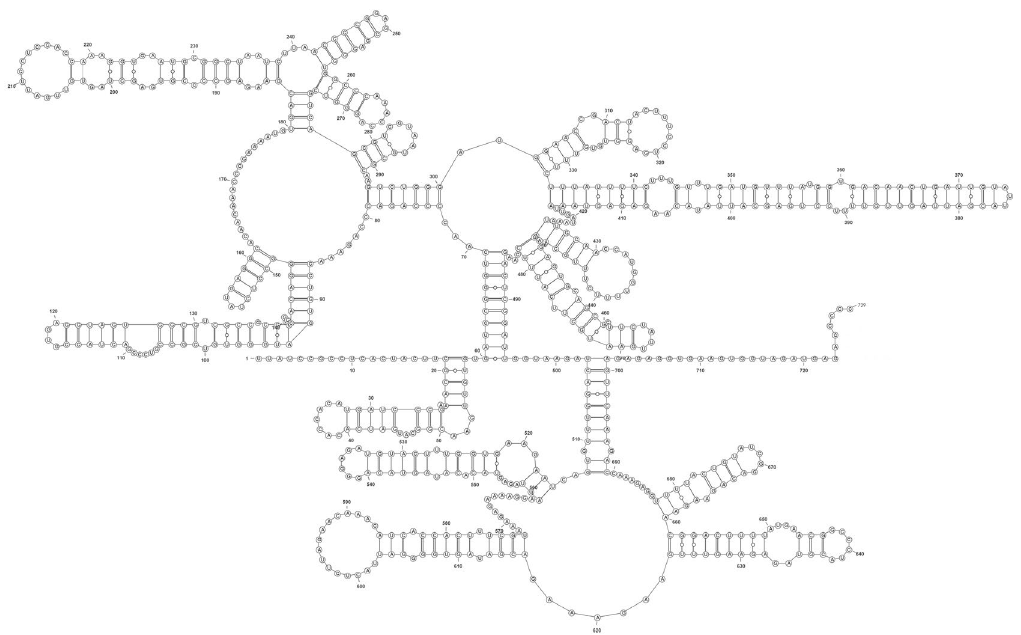
Figure 3. Secondary-structure model for PicoV-HMU-1. The structure was modeled using the aligned RNAalifold server of the ViennaRNA Web